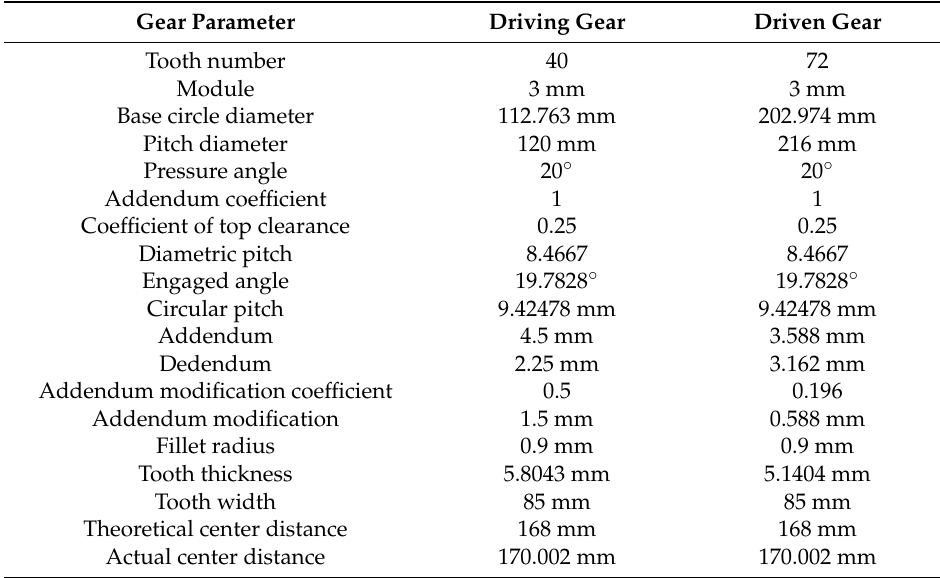
Table 1. List of gear parameters for the tested